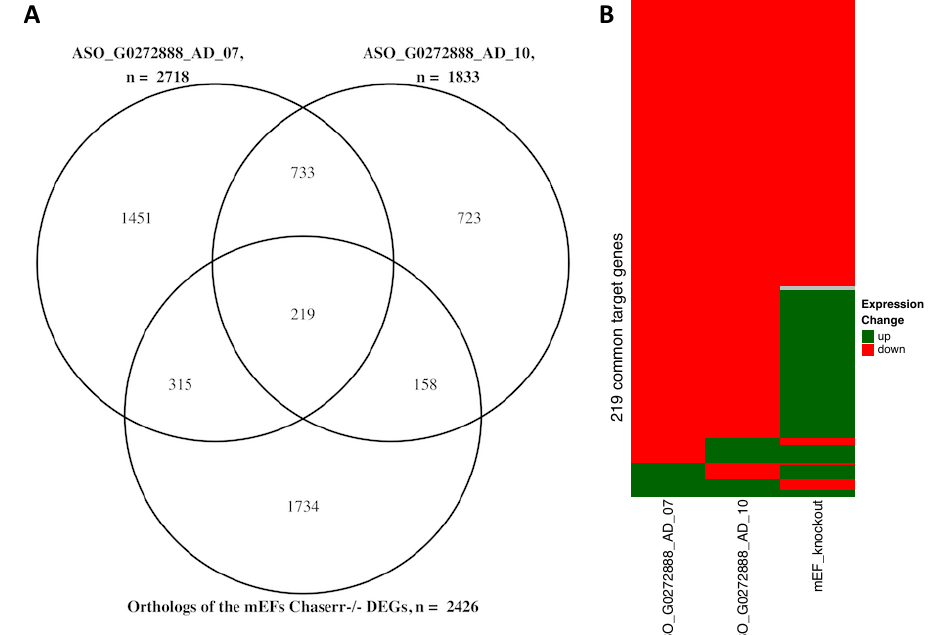
Figure 3. Differentially expressed genes (DEGs) observed in CHASERR knockdown experiments in human cells and in Chaserr -/- mouse embryonic fibroblasts (mEFs). ( A ) Overlap between the DEGs from three independent experiments. ( B ) Expression changes of the 219 genes that were classified as differentially expressed in all the three